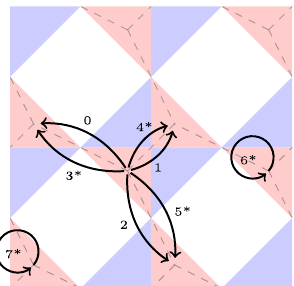
TABLE I. Number of single faults that can cause each type of edge to flip in the 3D matching graph for X -type-check